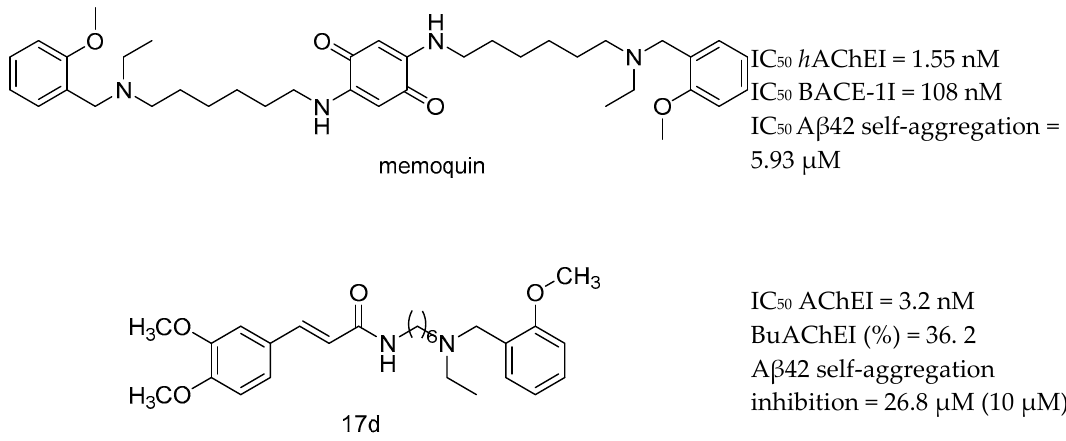
IC 50 h AChEI = 1.55 nM